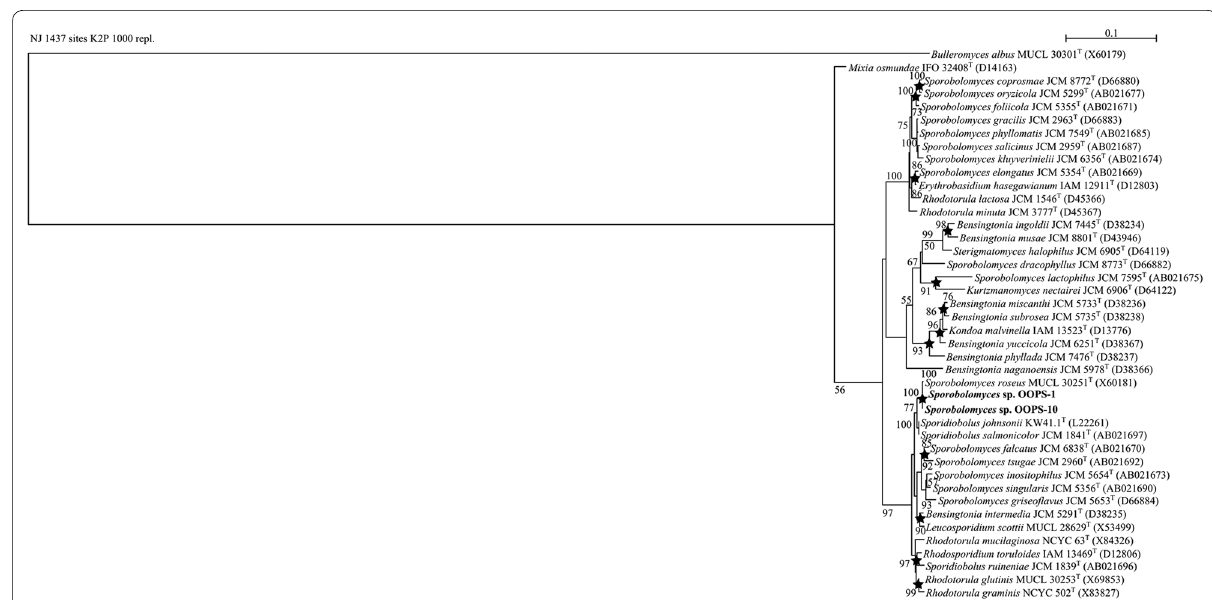
50% are shown at branch points. Filled circle, ≥